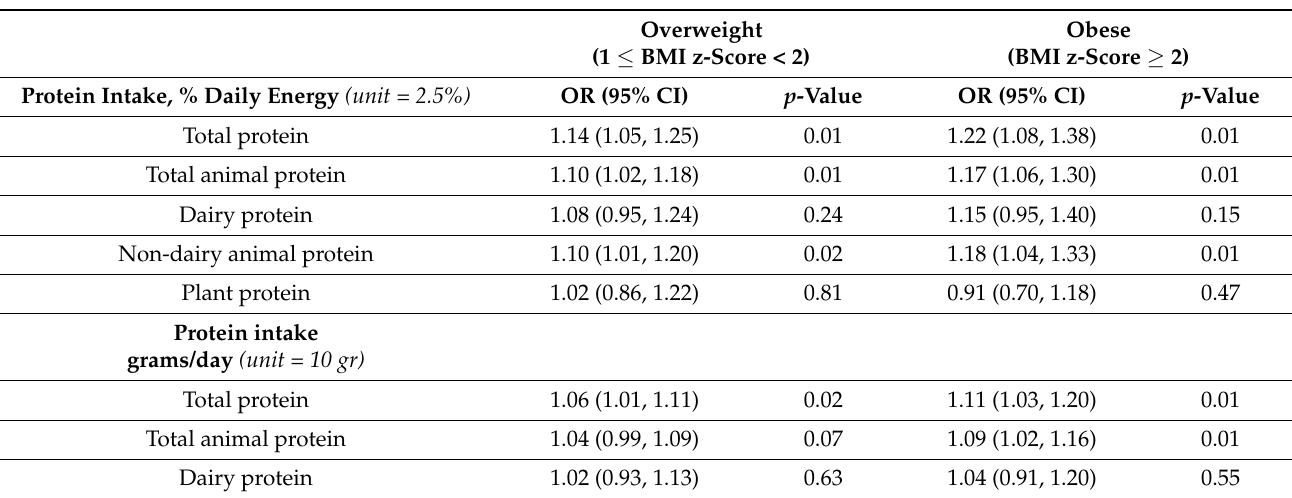
Figure 1. Multivariable logistic regression models, adjusted for age, sex, height z-score, socioeco- nomic status, physical activity, and total energy intake, for the association between protein intake (g/day)—in total and by source—and adolescent overweight/obesity. Table 2. Logistic regression analyses of the association between intake of total protein and protein from different sources with overweight and with obesity in study participants *.